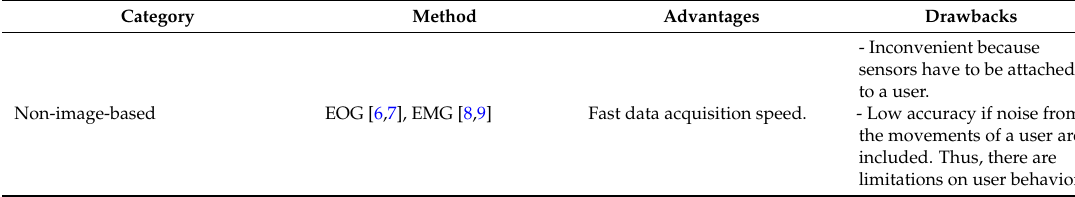
Table 1. Comparison of existing methods and the proposed